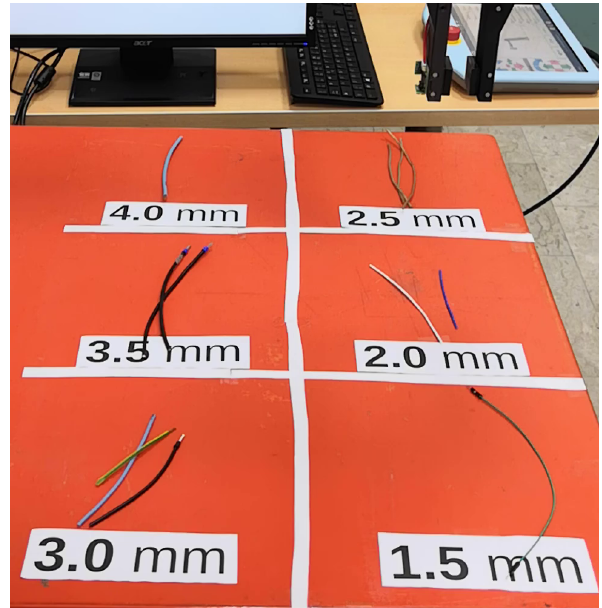
Figure 11. Wires at the end of the sorting